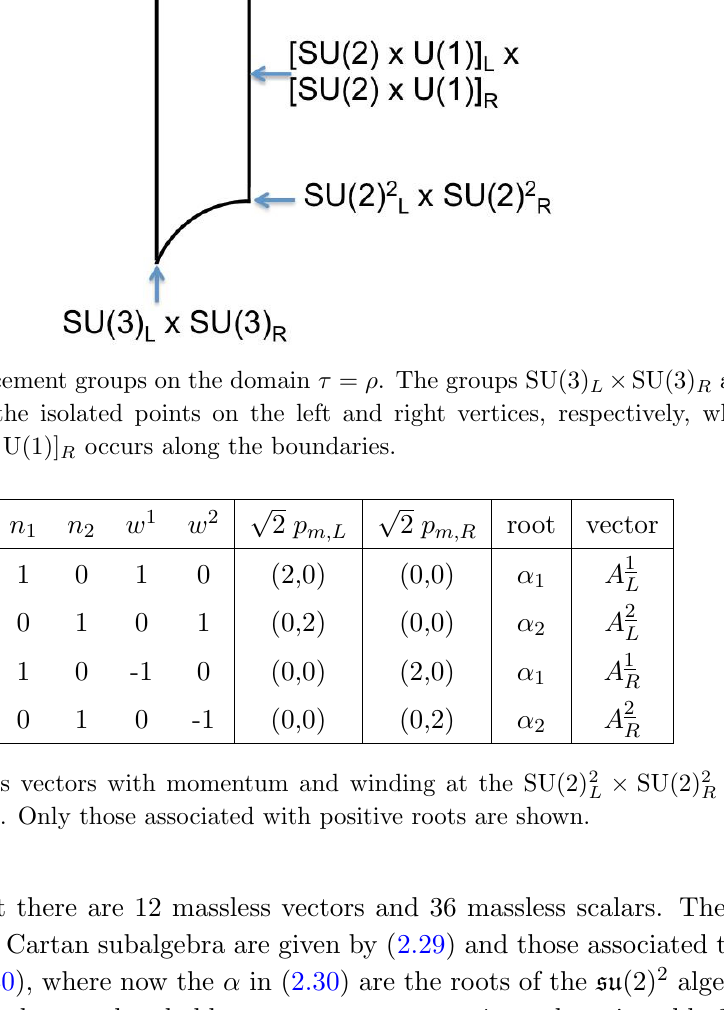
Table 1 . Massless vectors with momentum and winding at the SU(2) 2 point ( (cid:28); (cid:26) ) = ( i; i ). Only those associated with positive roots are shown.